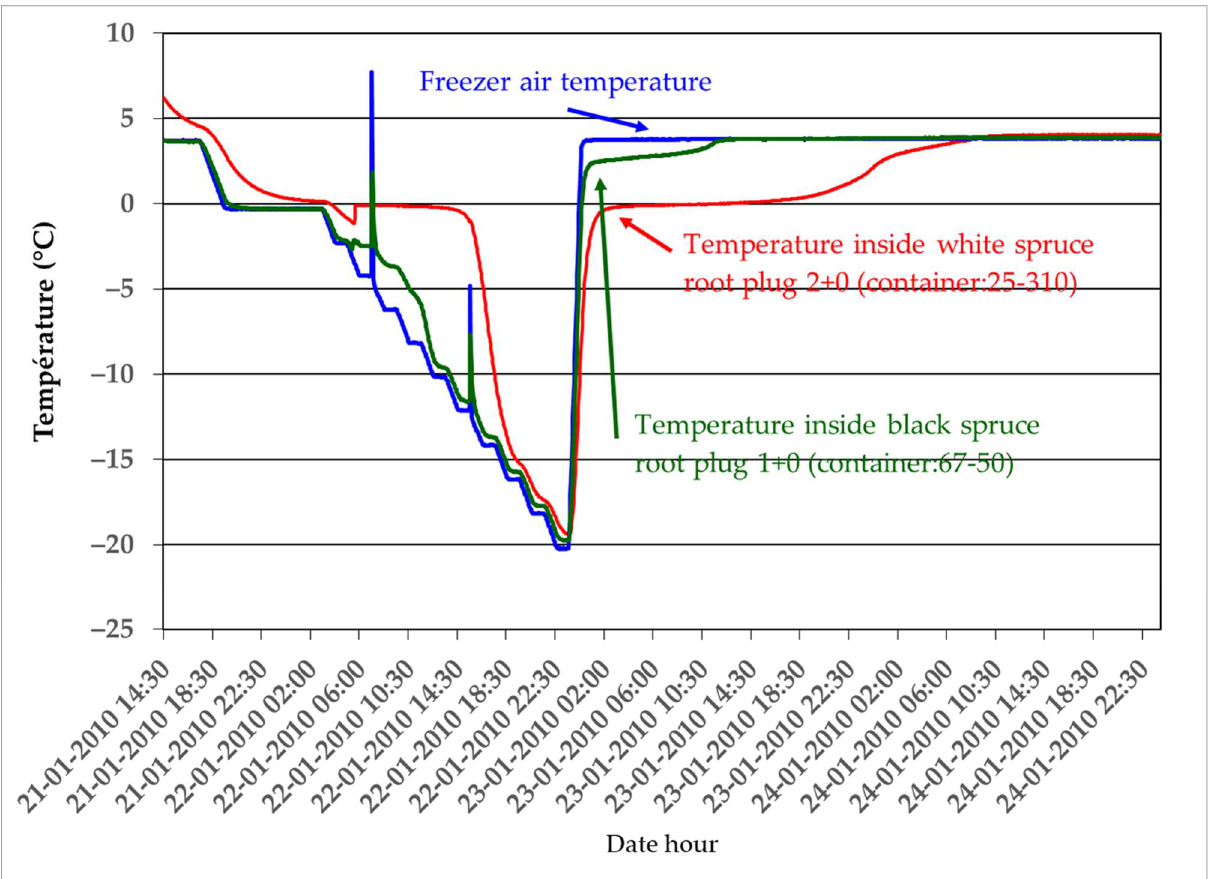
Figure 5. Temperatures registered in the air around the shoots and in the root plugs of black spruce (1 + 0) and white spruce (2 + 0) during artificial frost treatments. The seedlings were removed from the freezer once the target temperature around shoots (−4 °C, −12 °C, and −20 °C) had been reached and maintained for one hour. The peaks in blue indicate when the freezer door was opened to remove the seedlings.